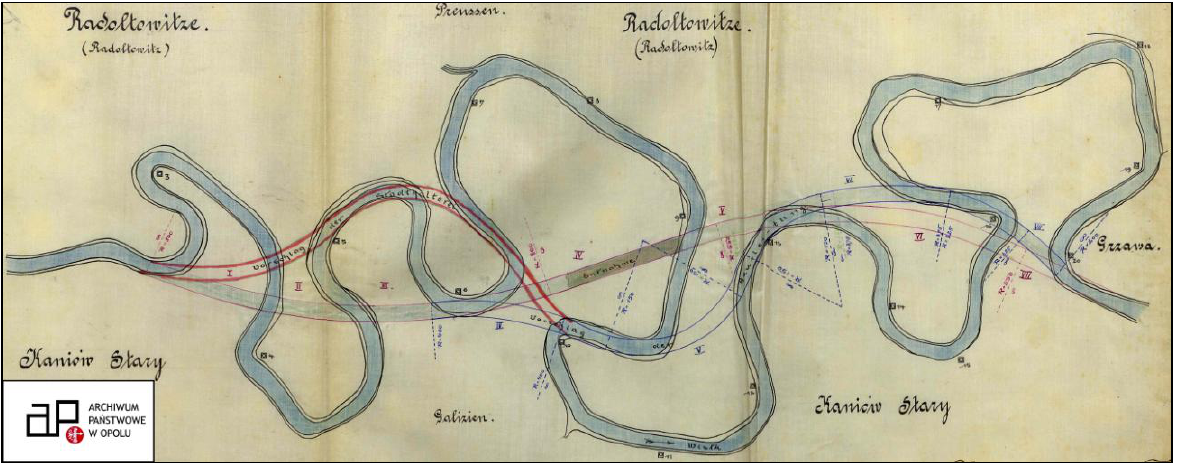
Fig. 10. River engineering work design – River Vistula valley in the vicinity of Kaniów (after Betrieb Weichsel Regulierung,